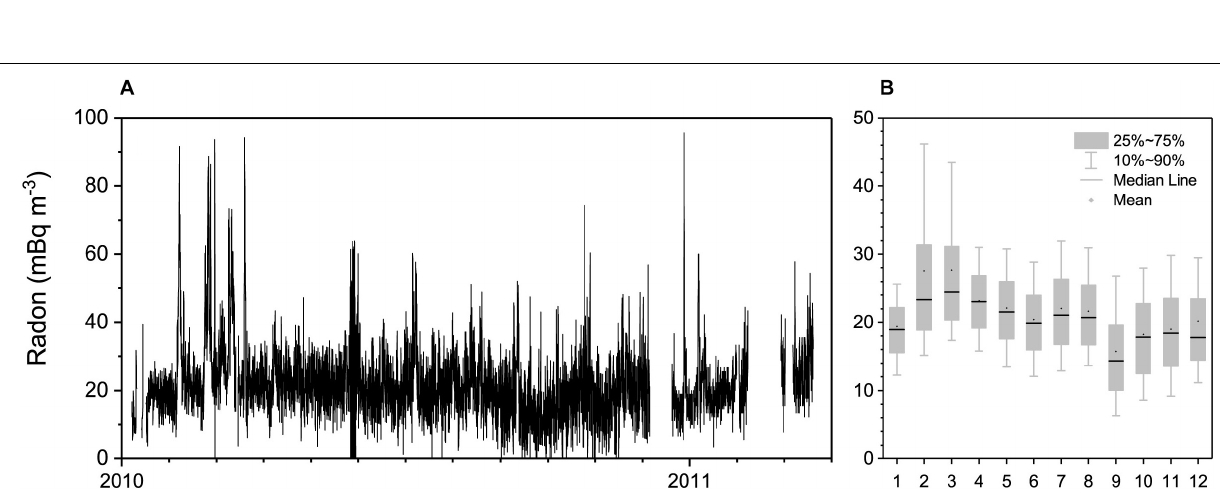
Frontiers in Earth Science |